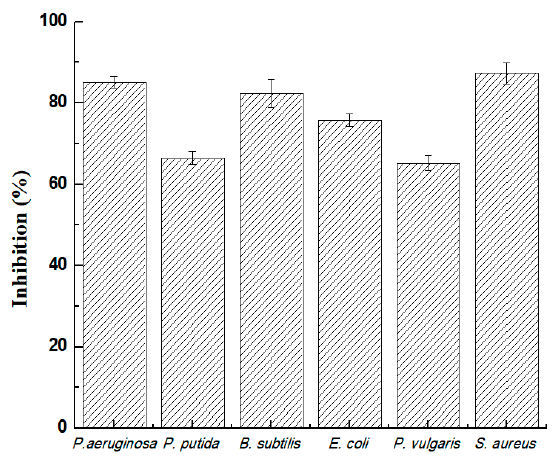
Figure 7. Antimicrobial potential of biosurfactant derived from NCIM 2903 against Ps. aeruginosa MTCC 2297, Ps. putida MTCC 2467, B. subtilis MTCC 2423, E. coli NCIM 2065, P. vulgaris NCIM 2027 and S. aureus NCIM 2079.